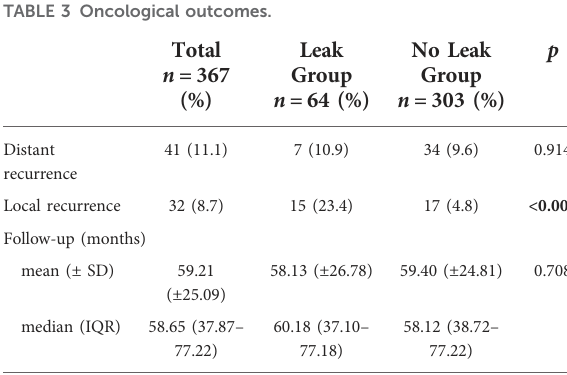
TABLE 3 Oncological outcomes.